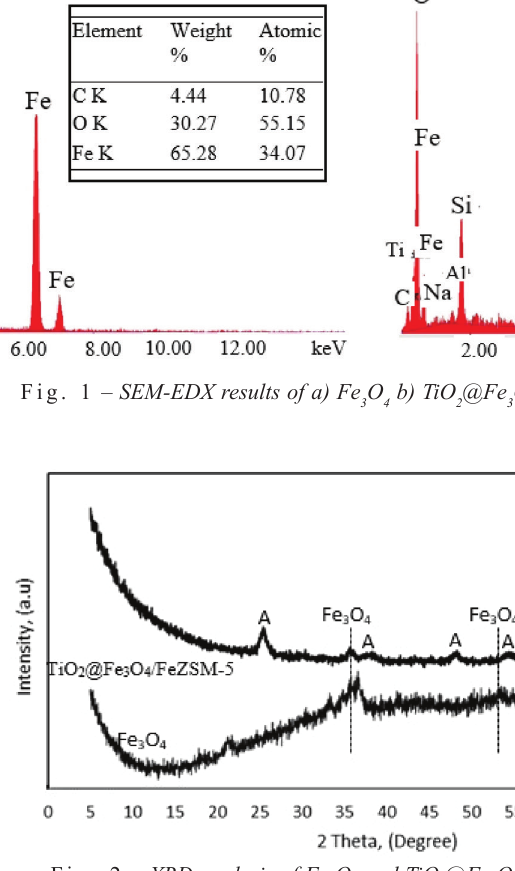
Fig. 2 – XRD analysis of Fe